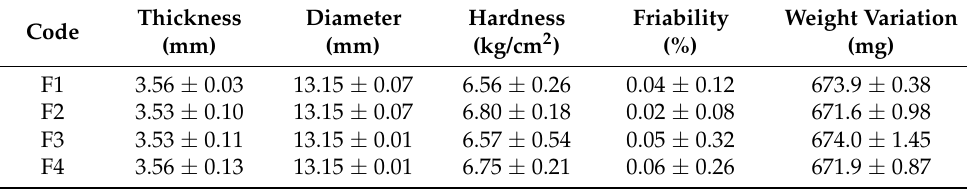
Table 3. Results of physical quality control tests.